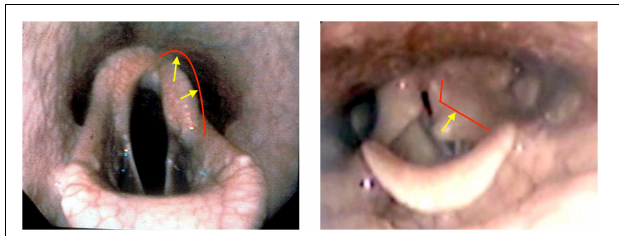
FIGURE 3 | Endoscopic photographic images during exercise of: (left) left-sided recurrent laryngeal neuropathy in an equine. (Right) Left laryngeal hemiplegia in a human. Red lines denote expected position of arytenoid cartilage in a normal subject. Yellow arrows denote degree of collapse to